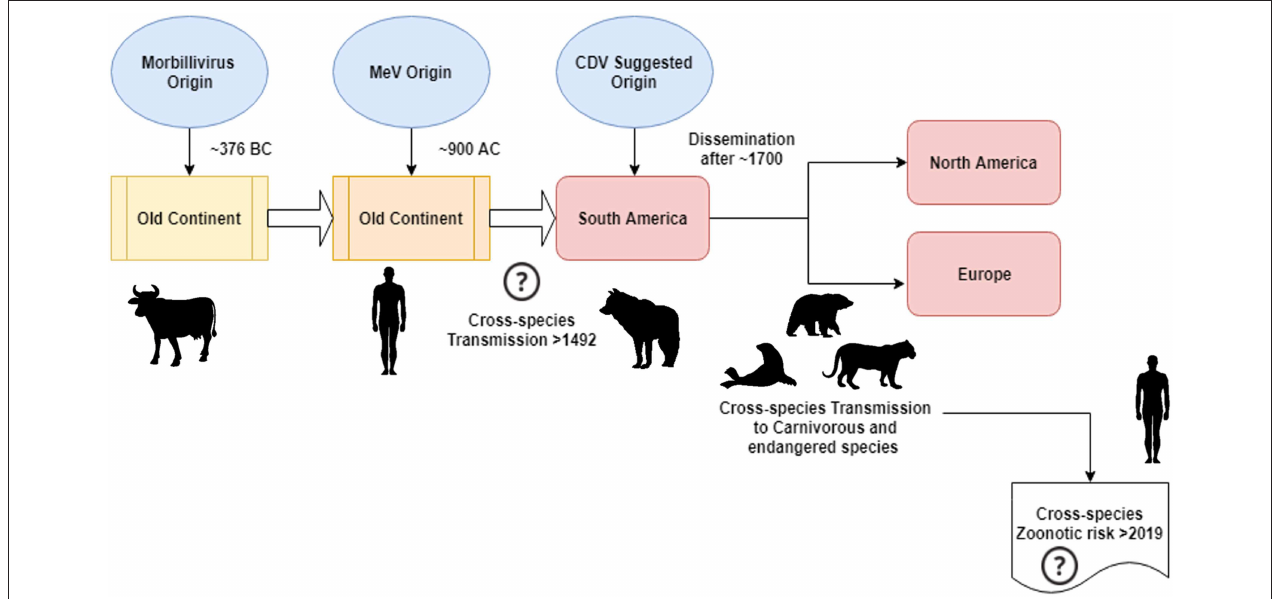
FIGURE 1 | Schematic representation of the possible canine morbillivirus (CDV) evolutionary transmission route. See text for